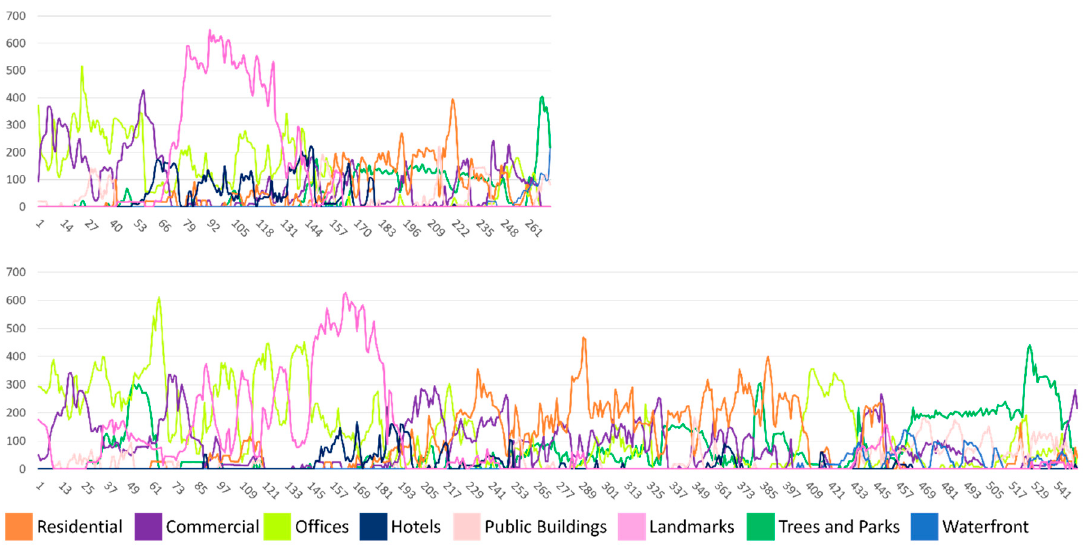
Figure 8. Geovisualization graphs of case study 1 generated by the 3D visual analysis tool for all feature category types, produced for the shortest route ( top ) and the tourism route ( bottom ).